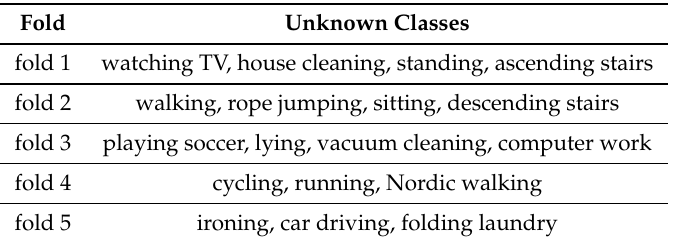
Table 3. Foldings of the PAMAP2 classes.